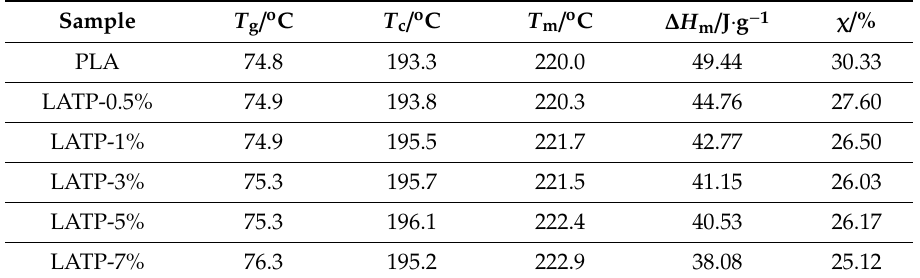
/ PVA nanocomposites according to the thermal Table 2. The related results of LDHs@TA-Ti/PVA nanocomposites according to the thermal analysis. Table 2. The related results of LDHs@TA-Ti